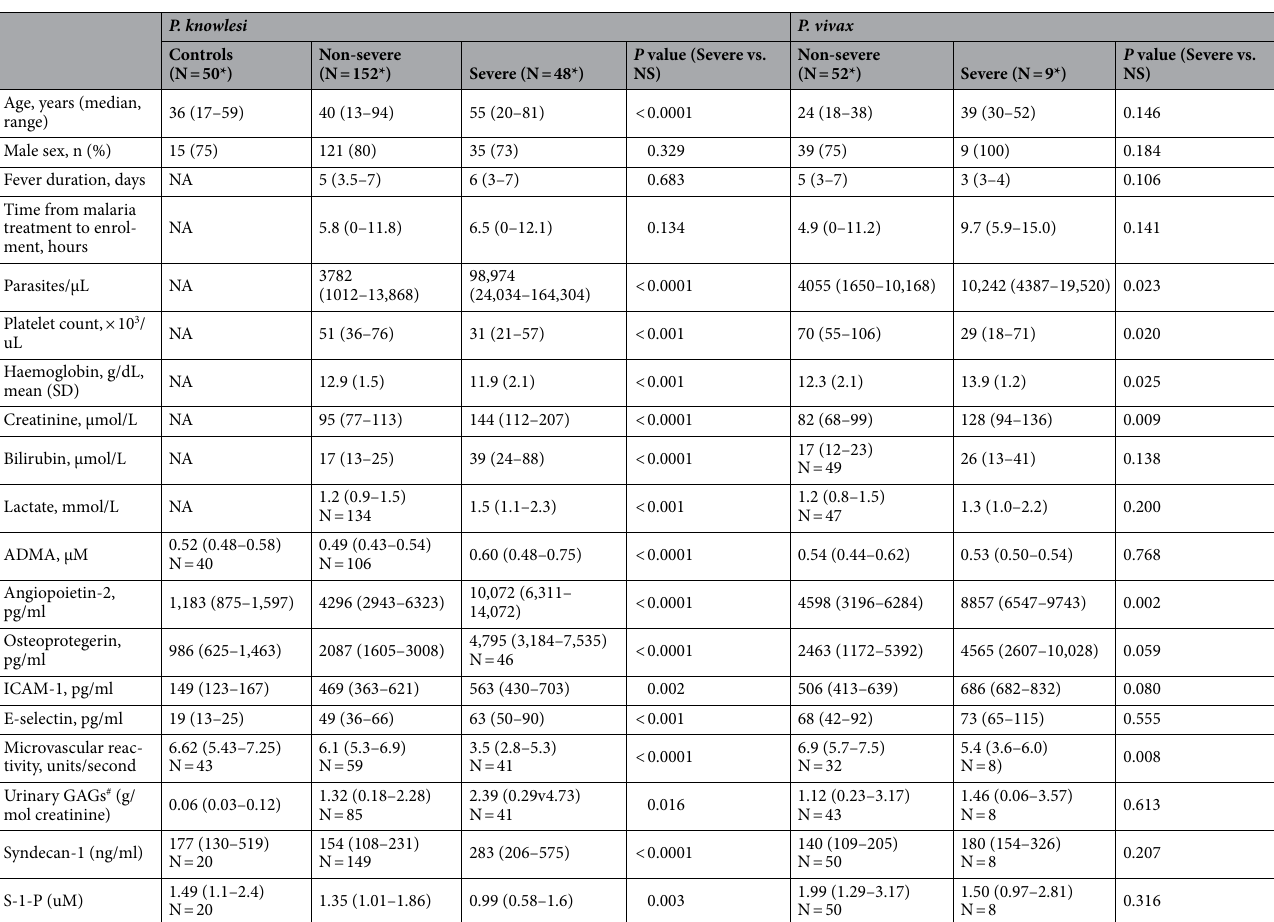
Table 1. Baseline characteristics. Numbers indicate median (IQR) unless otherwise indicated. NA not assessed, NS non-severe, GAGs glycosaminoglycans, ADMA asymmetric dimethylarginine, ADMA ICAM-1: intercellular adhesion molecule. *Unless otherwise indicated; # GAGs above level of detection in 63% and 62% of patients with severe P. knowlesi and P. vivax malaria respectively, and in 69% and 67% of patients with non- severe P. knowlesi and P. vivax respectively. GAGs above level of detection in only 6% of